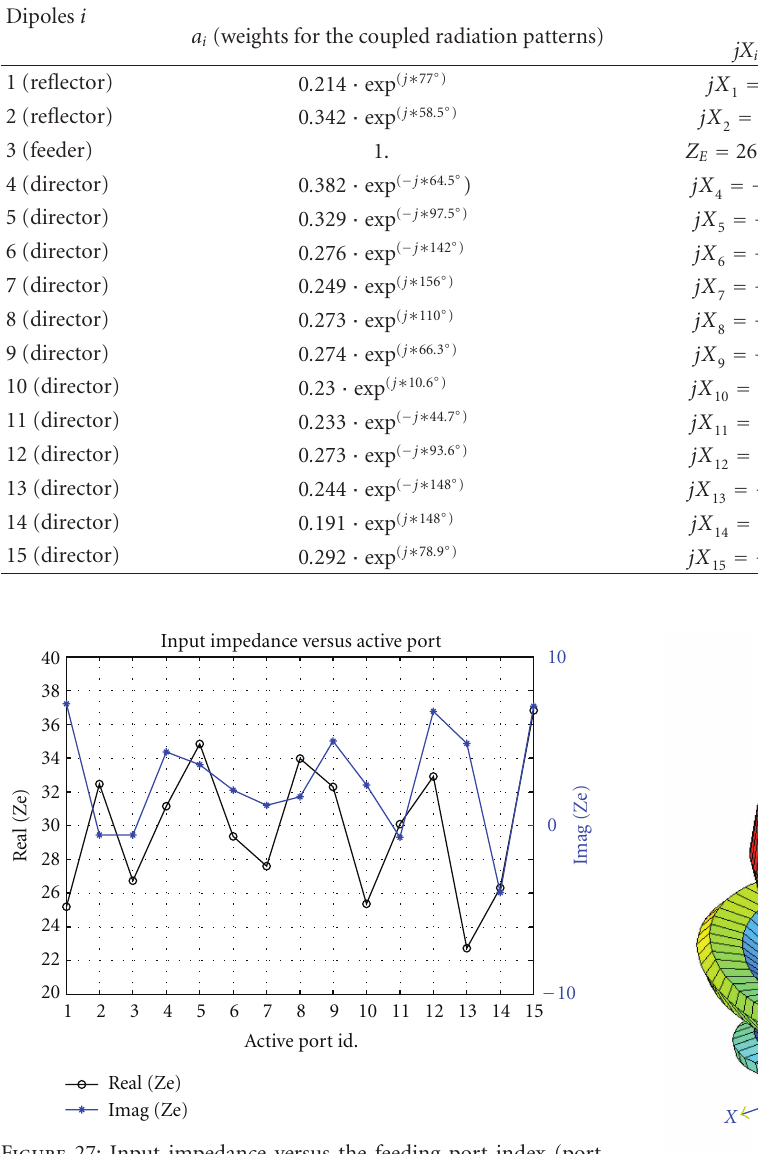
Reactive loads ( jX i ) and input impedance (Z E ) that